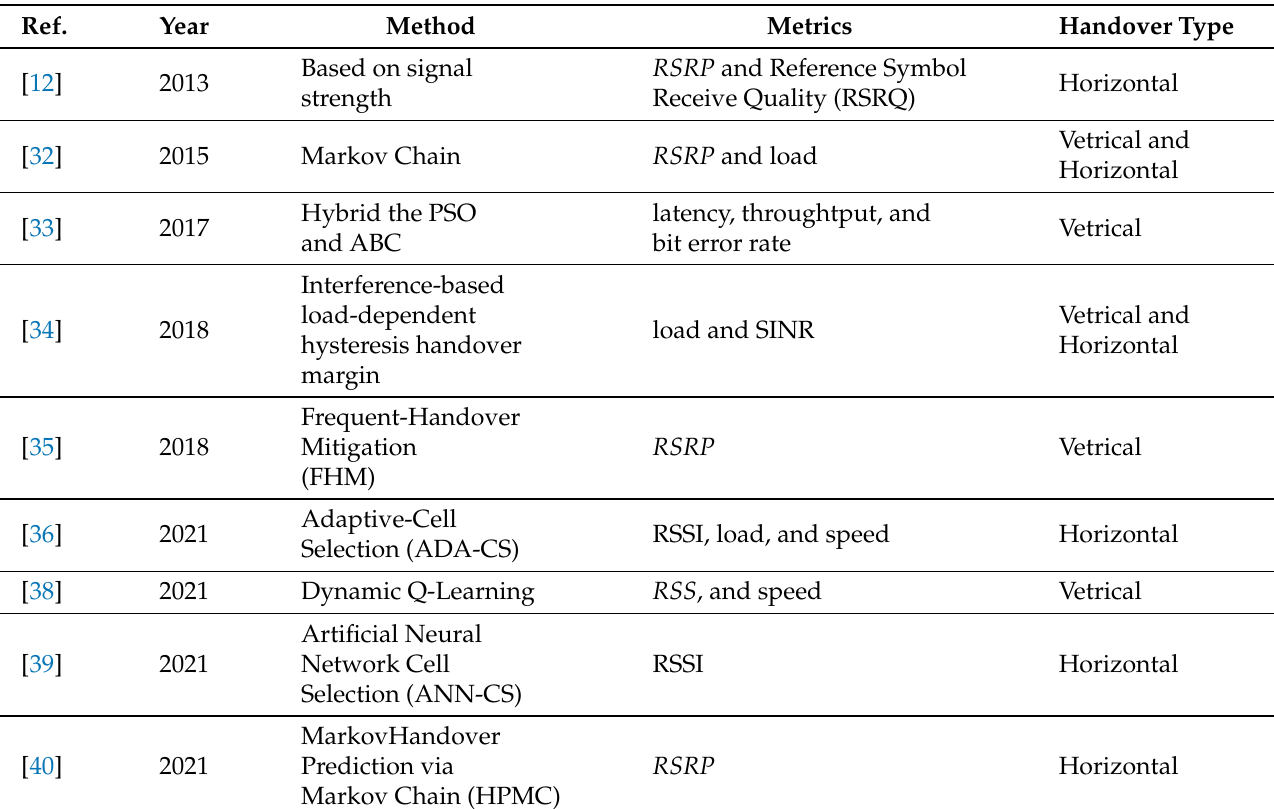
Table 1. Mechanisms